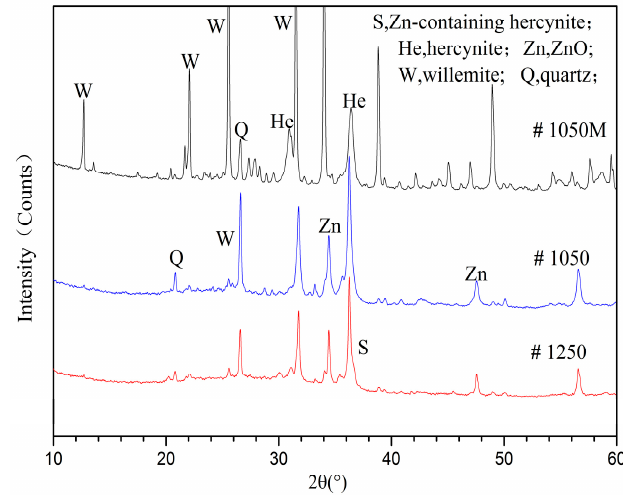
Figure 4. XRD patterns for 1050 and 1250 °C DTF ash (blue, red, respectively) and 1050 °C MF ash (black) of SH light coal.